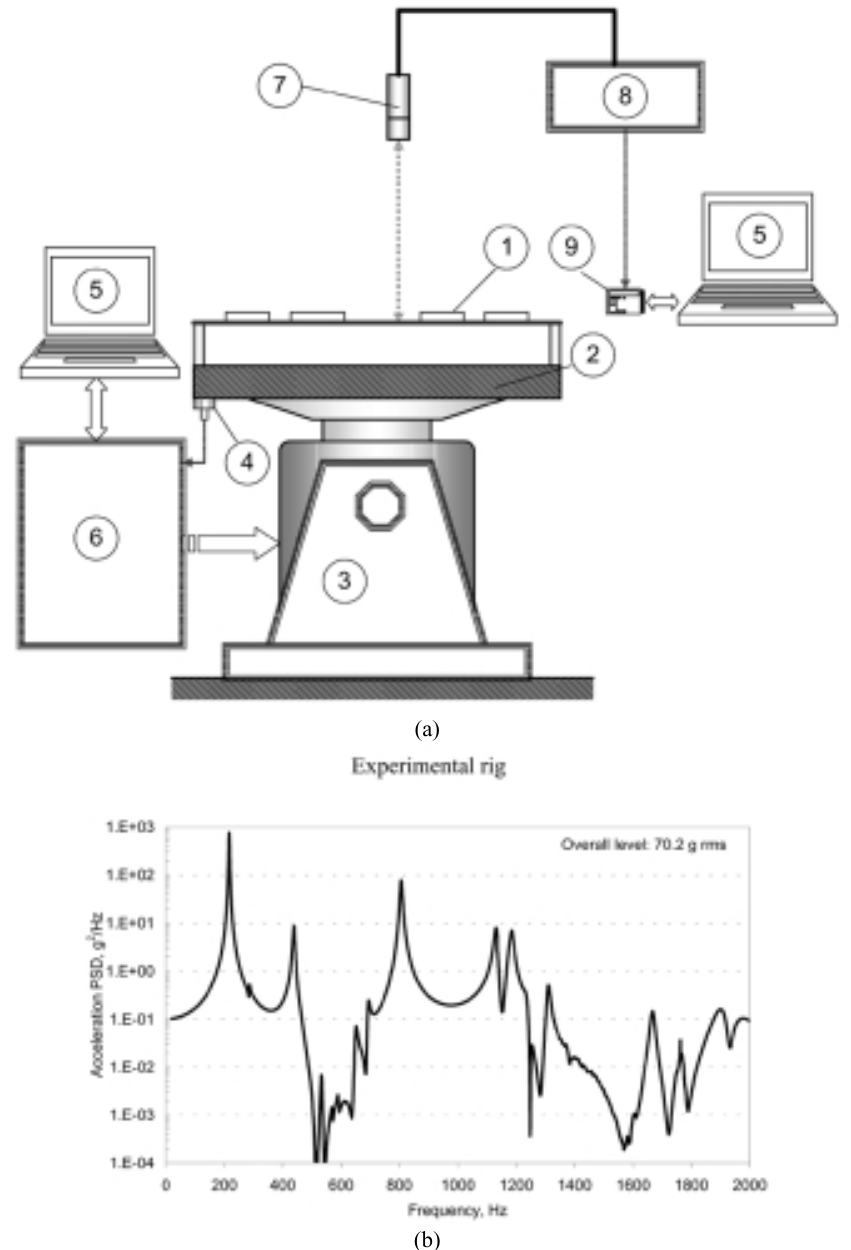
Fig. 2. Schematics of experimental rig and typical vibration response. a) Experimental rig; b) Experimentally measured PSD of absolute acceleration in the critical point of the original